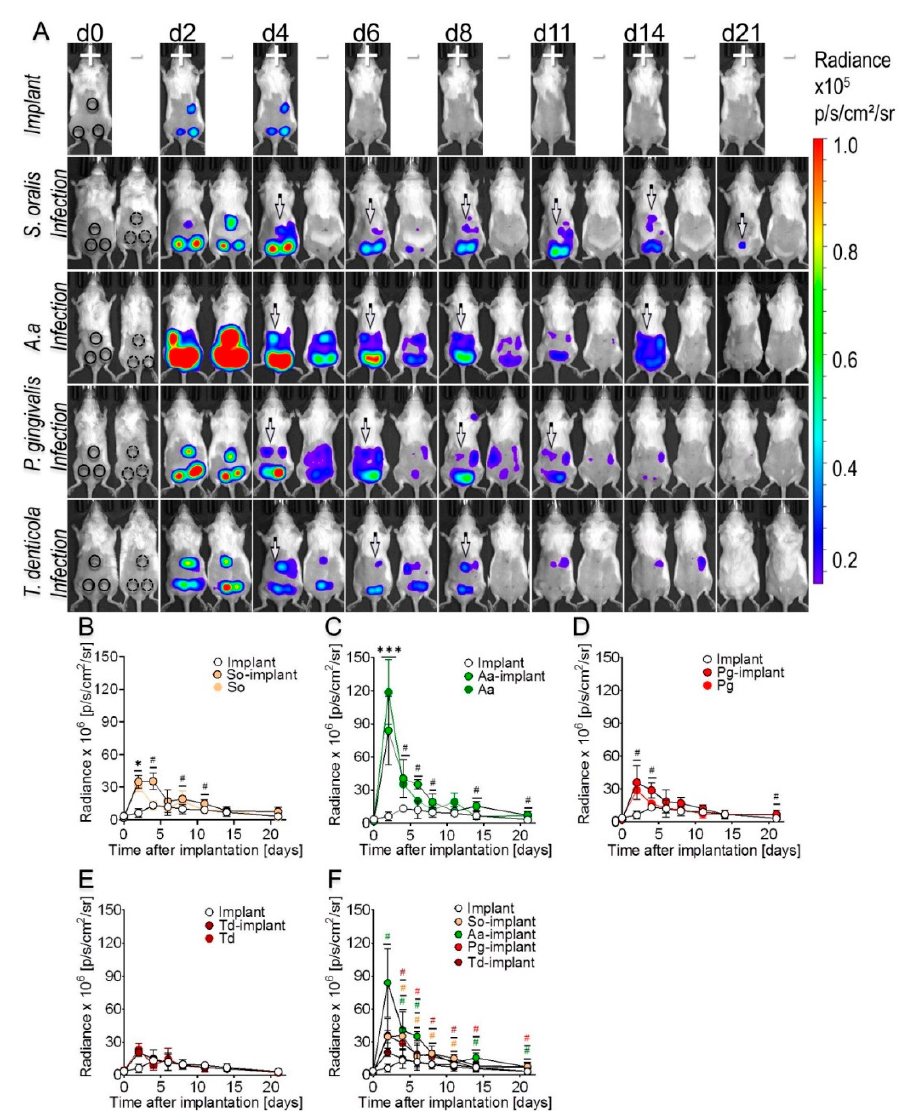
Figure 2. Interferon beta (IFN ‐β ) induction during biomaterial ‐ associated bacterial infections. ( A ) Black circles in each mouse show areas containing sterile implants or implants infected with S. oralis ( So ), A. actinomycetemcomitans ( Aa ), P. gingivalis ( Pg ) or T. denticola ( Td ) at day 0. Dashed black circles on day 0 show the regions for infected sham operated tissues. IFN luciferase luminescence intensity around implants (+) and sham ‐ operated tissues ( − ) is indicated by bioluminescent patches (d2–d21). The illustration shows images from a typical single experiment selected from a group of three animals. In vivo measured bioluminescent signals from the sites of implantations were quantified and are shown here as radiance at the indicated time points ( B – F ). ( B – E ), illustrate IFN ‐β kinetics in response to S. oralis (yellow), A. actinomycetemcomitans (green), P. gingivalis (red), and T. denticola (dark red) infections of subcutaneous implants (circles with border), sham ‐ operated tissues (circles without